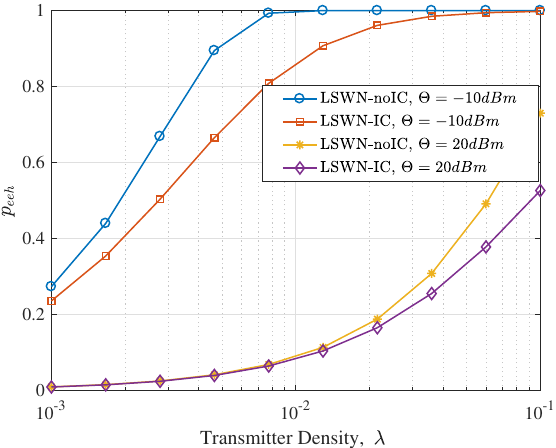
Figure 10. Effective energy harvesting probability versus transmitter density with α = 4, d = 2 and P et = 30